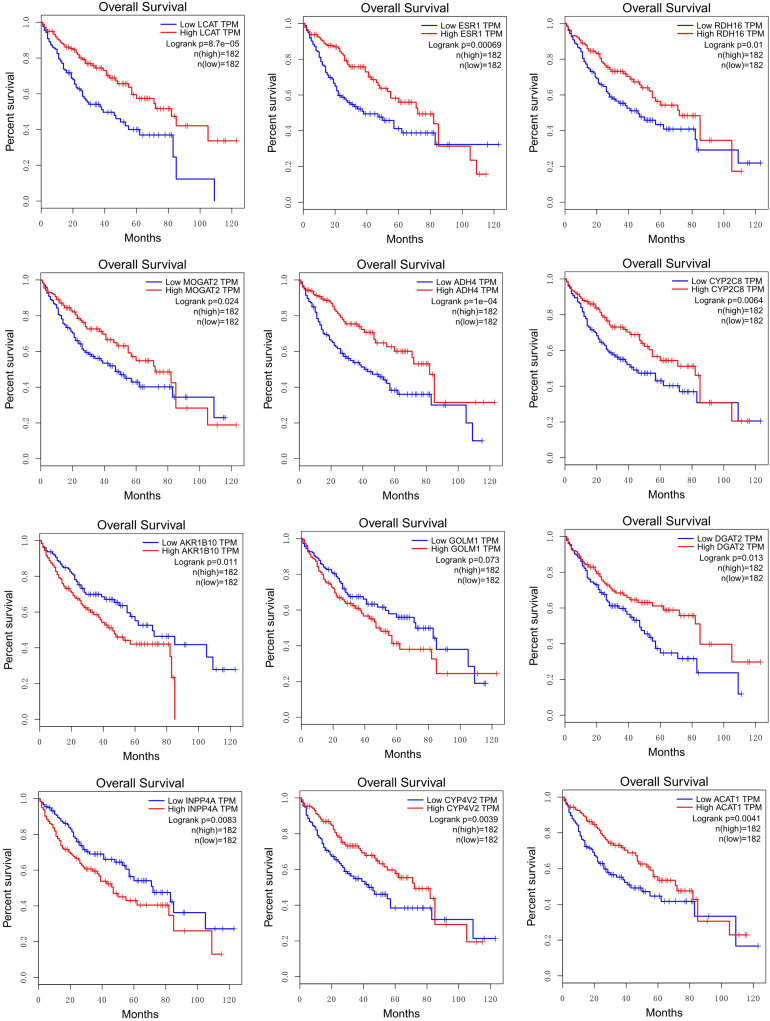
Correlations between survival rates and the expression levels of HCC-specific or consistently regulated LMGs (shown in bold in Table 2).